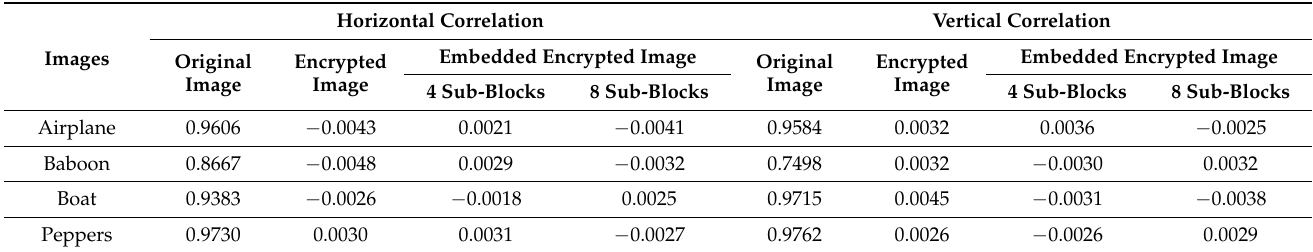
Table 8. Correlation distribution of images in different directions when the pixel block size is 16 × 16.